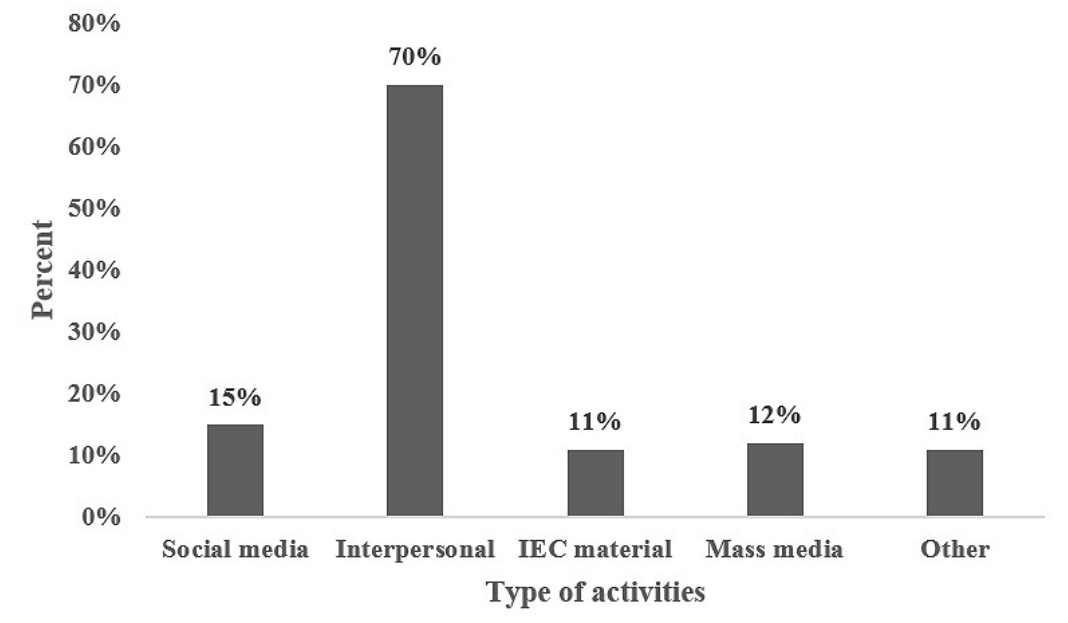
Figure 4. Promotional activities used (N=39,800; multiple counts), (Information, education, and communication = IEC).